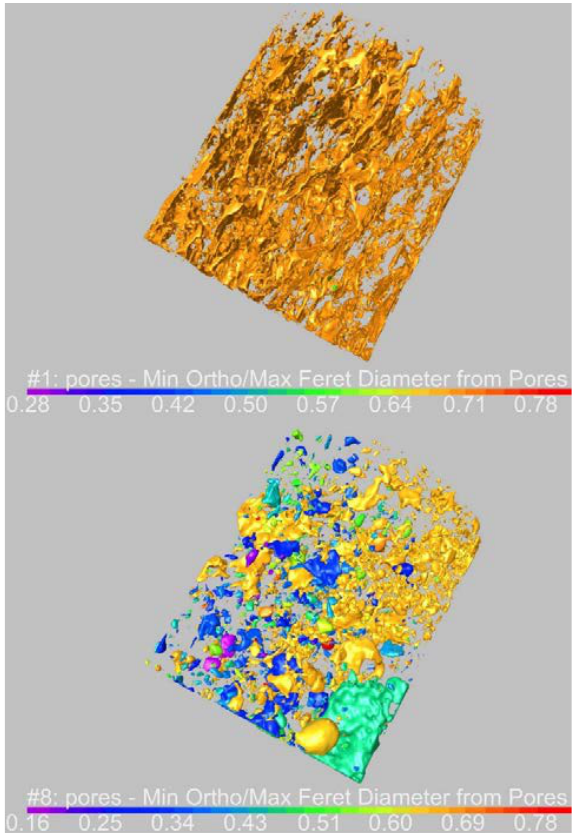
Figure 13. Minimum orthogonal Feret diameter/maximum Feret diameter. A sample from ceramic 1 (900 °C) ( upper ) compared with one from ceramic 8 (1150 °C) ( lower ).